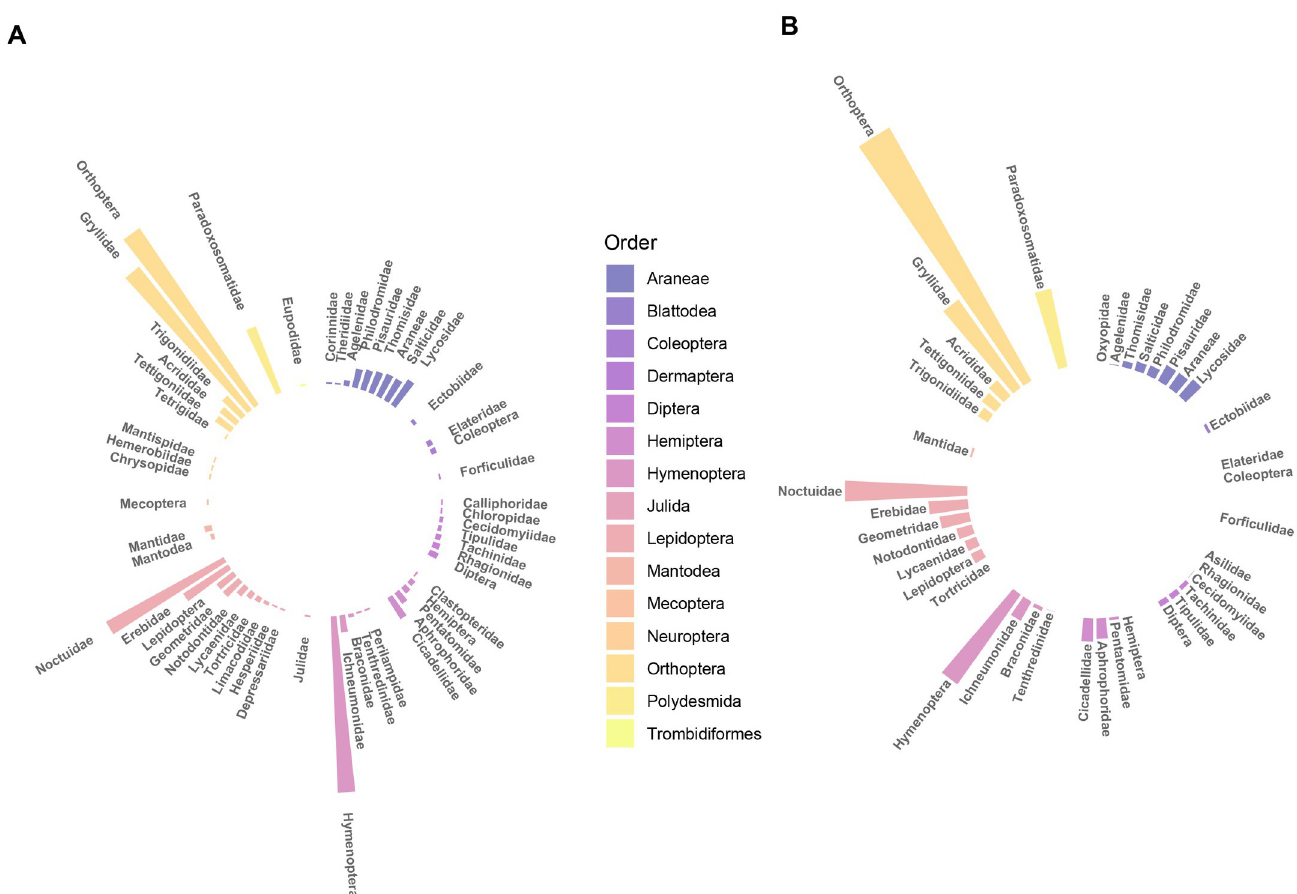
Fig 2. Circular barcharts representing rank abundance of (A) pooled frequency of occurrence (whether taxa are present or not based on > 10 reads in a sample) for arthropod taxa in fecal samples, and (B) pooled rarefied reads for taxa observed in wren fecal samples.